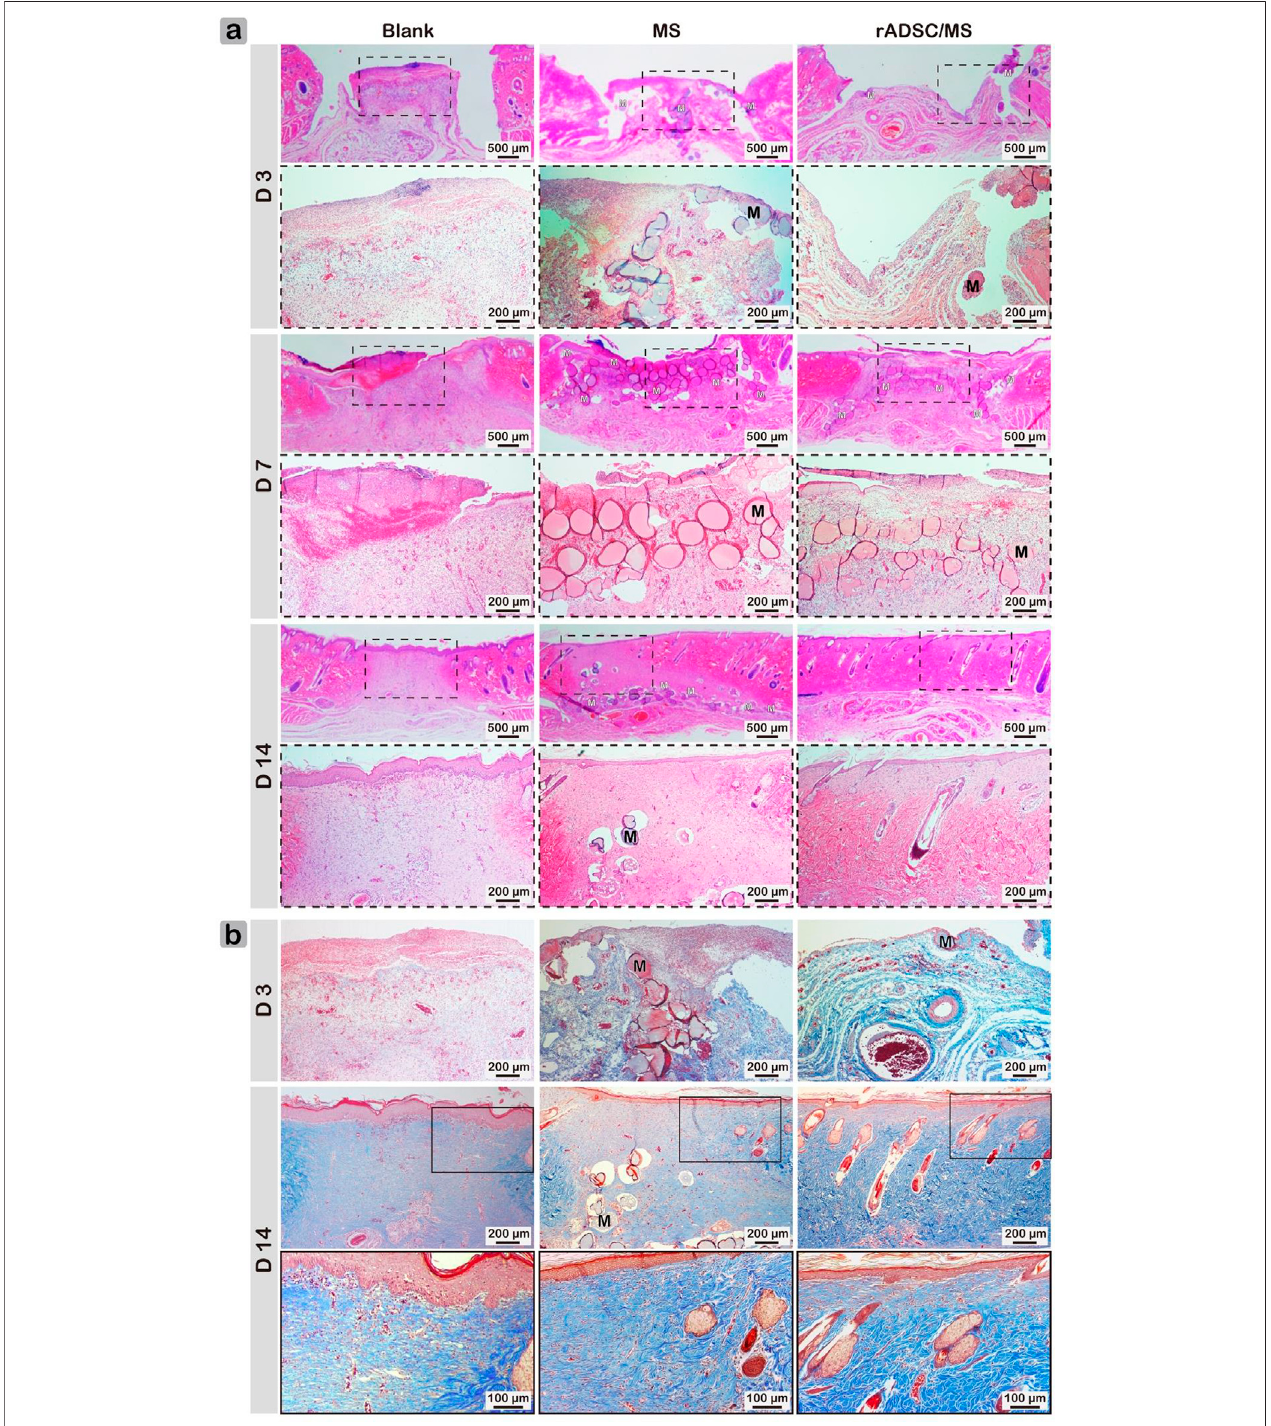
FIGURE 4 | Representative (A) hematoxylin/eosin- and (B) Masson ’ s Trichrome-stained wound sections for blank, MS, and rADSC/MS groups on days 3, 7, and 14. “ M ” represents gelatin microspheres. Microspheres functioned as scaffolds to fasten wound healing and enhance collagen deposition; with encapsulation of rADSCs, enhancing effect was more signi fi cant. On day 14, arrangement of collagen fi bers for rADSC/MS group was similar to unwounded skin.